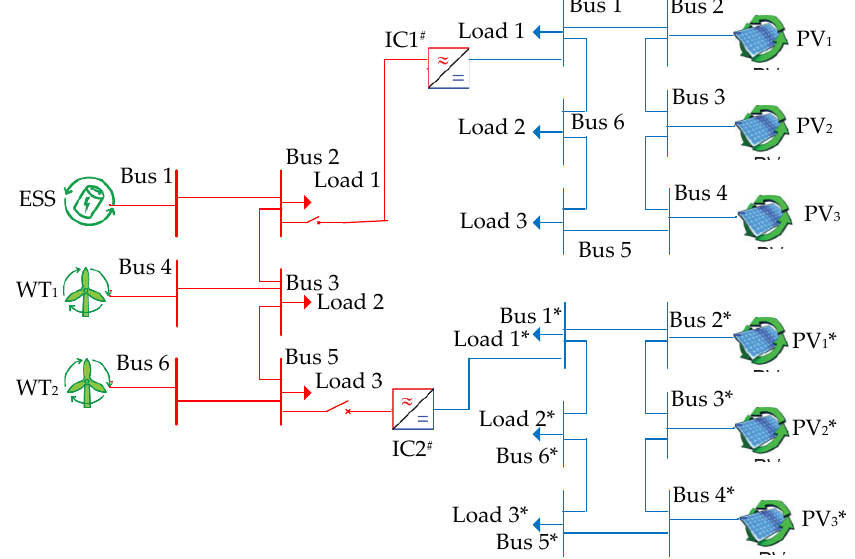
Figure 6. Multi-DC subgrids IHMG test system in mode 1.